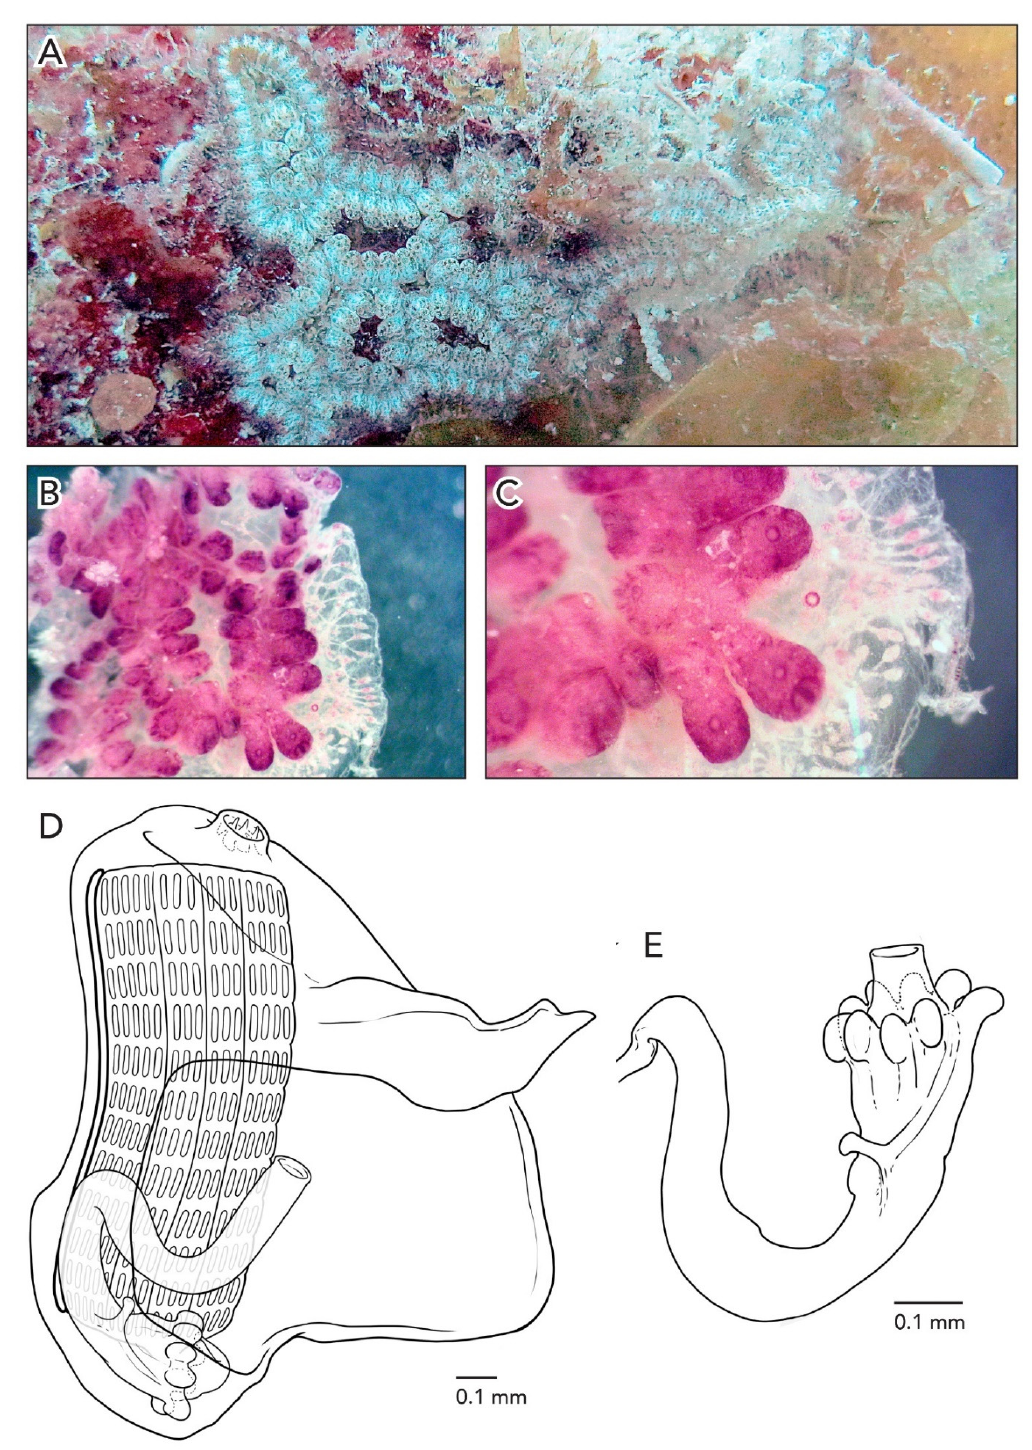
per half-row on each side of the body, with the following formula DL5v3v3v4 E on the right side, and DL5v3v3v4E on the left.